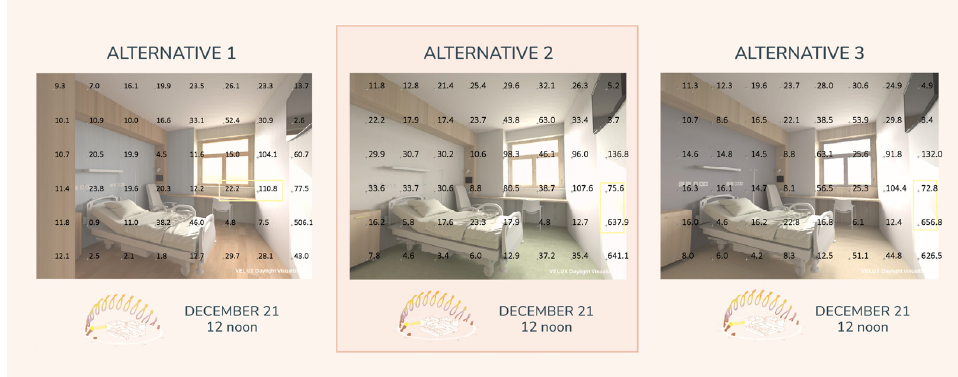
Figure 12. Alternative proposals for the design of finishing materials in room 1.